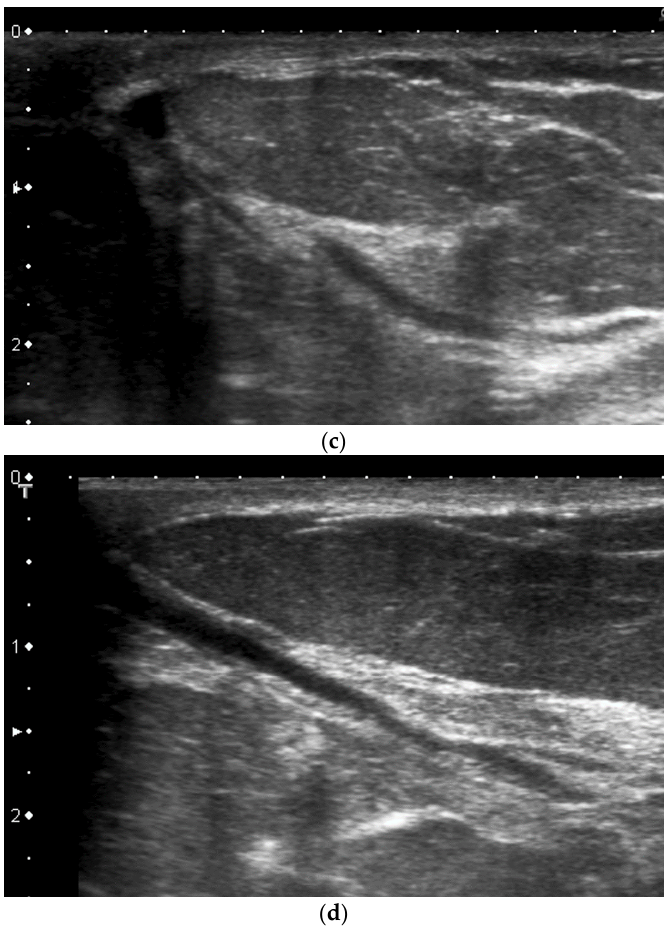
Figure 10. Peripheral compression technique can aid to visualize the peripheral segments of retroareolar ducts. Photograph of the manoeuver ( a ) and its corresponding drawing ( b ). US pre manoeuver ( c ) and post manoeuver ( d ) images.